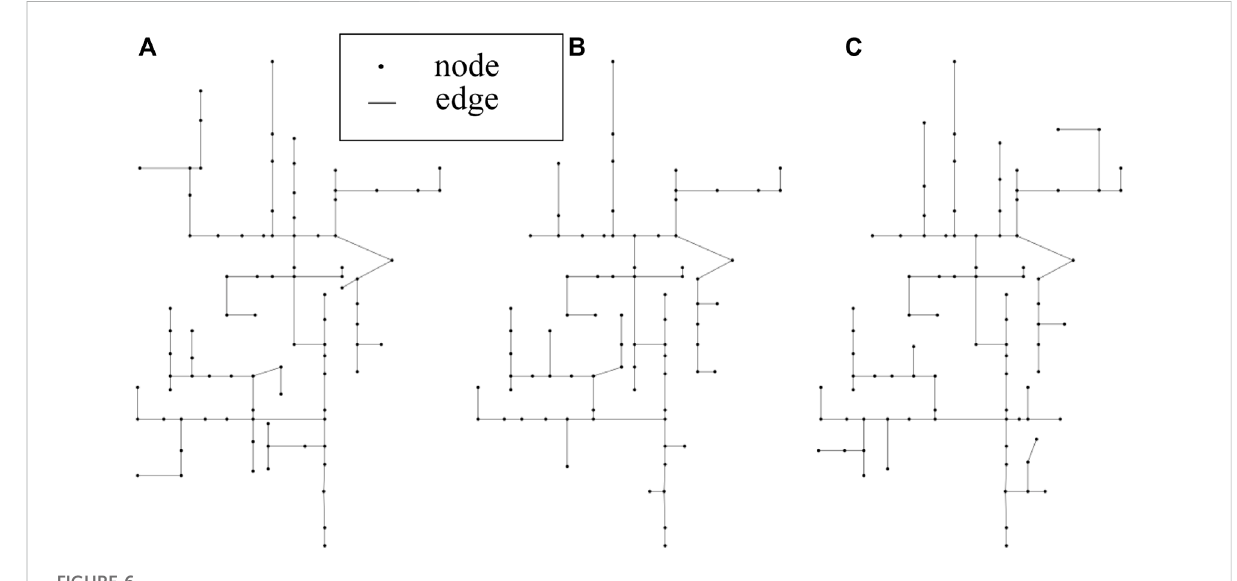
FIGURE 6 The topology of each phase in feeder2.